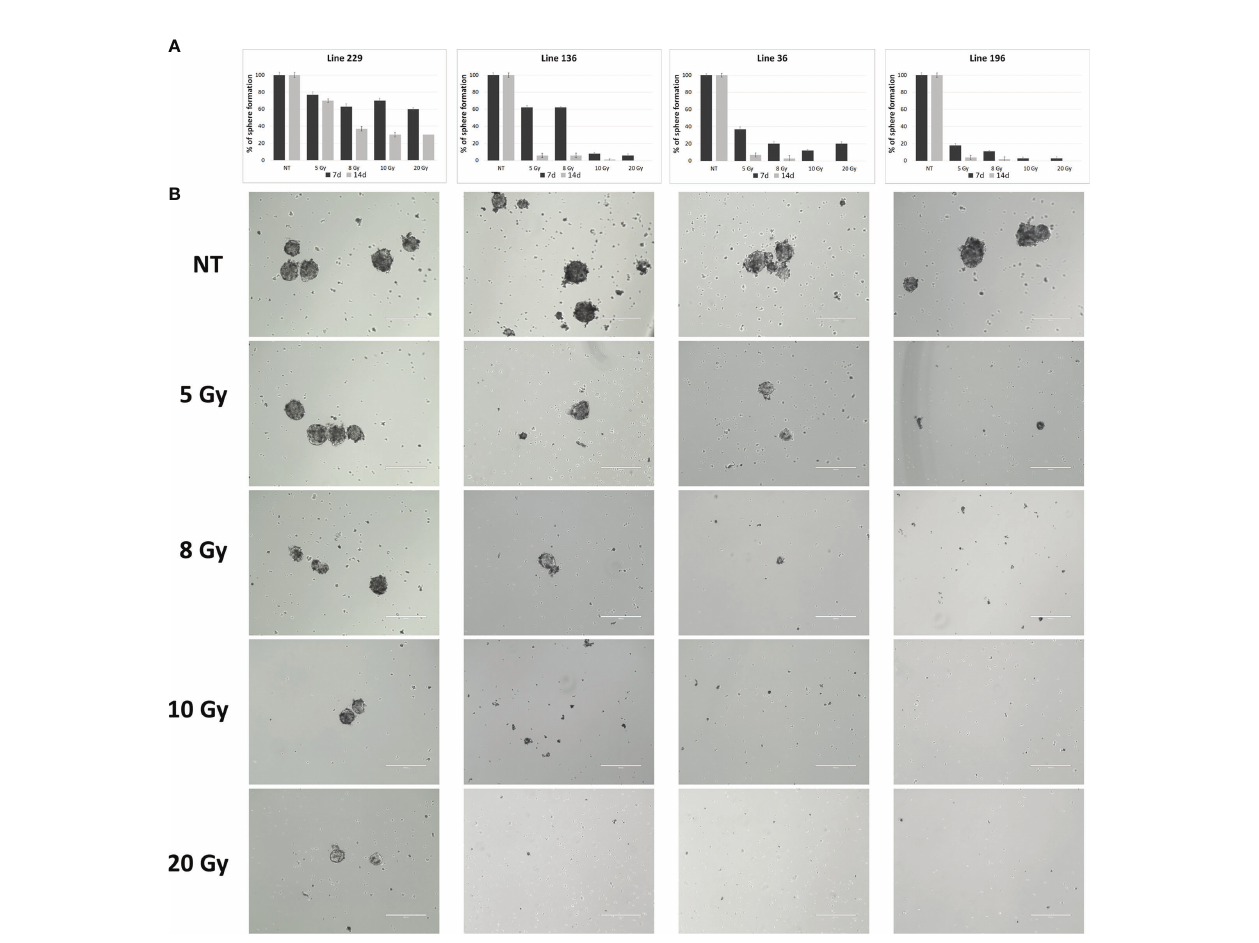
FIGURE 3 | Sphere formation assay. (A) Quantitative representation of sphere formation capabilities of the four lines after treatment with different doses (number of spheres per FOV after treatment/number of spheres per FOV before treatment, four replicates for each dose/line). (B) Representative images of sphere formation